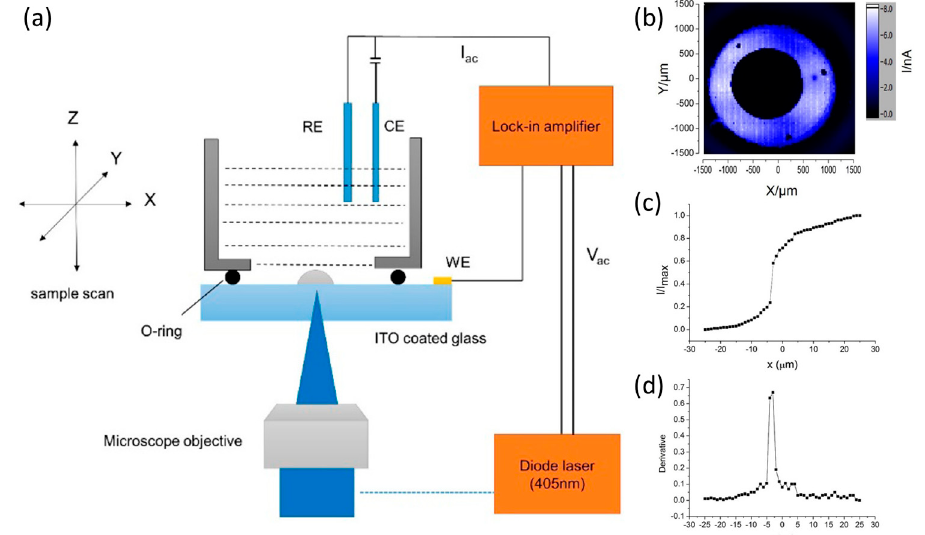
Figure 3. ( a ) Schematic of the LAPS set-up with ITO coated glass; ( b ) The LAPS image of the PMMA dot; ( c ) Normalized photocurrent-position curve scanning across the edge of PMMA dot; ( d ) the first derivative of (B) with the FWHM of 2.3 µm. Reprinted (adapted) with permission from Zhang et al. [50] Copyright (2019) American Chemical Society.